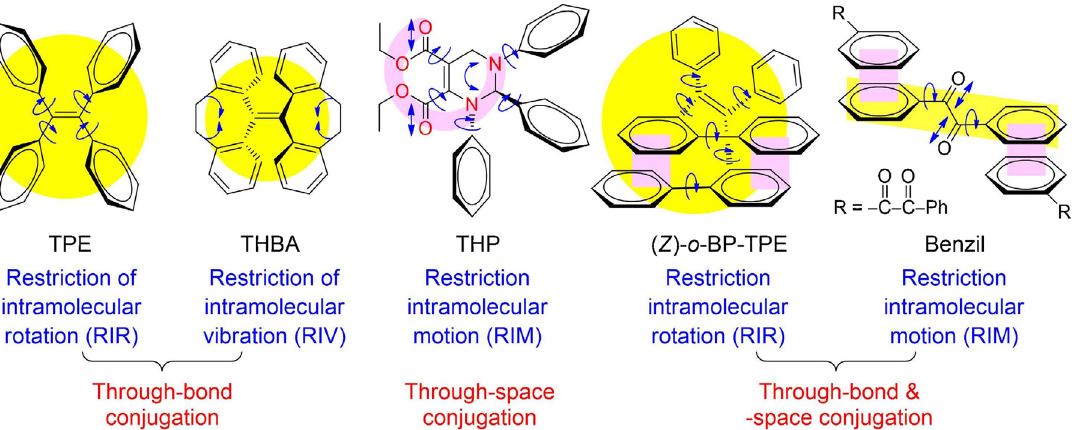
Figure 20. Different restricted motions that can be leveraged to promote AIE in COFs [189]. Repro- duced with permission from ref. [189]. Copyright 2015 Elsevier.